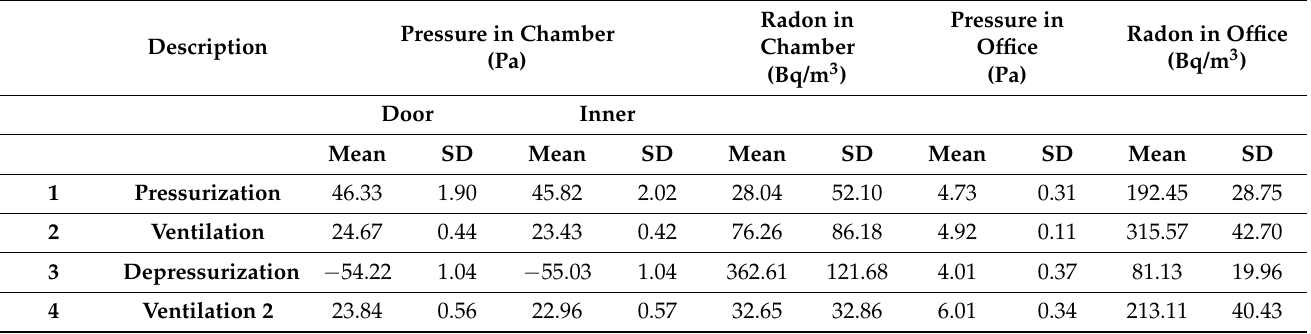
Figure 13. ( a ) Radon levels measured in the acoustic wing. ( b ) Pressure measures in the acoustic wing. (0) Initial state and setting of recovery levels. Reverberation chamber closed. (1) Pressurization test, (2) forced ventilation test, (3) depressurization test, (4) forced ventilation test (repeated). Table 5. Acoustic wing. Summary of radon levels and pressure differences achieved at mitigation tests. Reference level for pressure in the neighboring